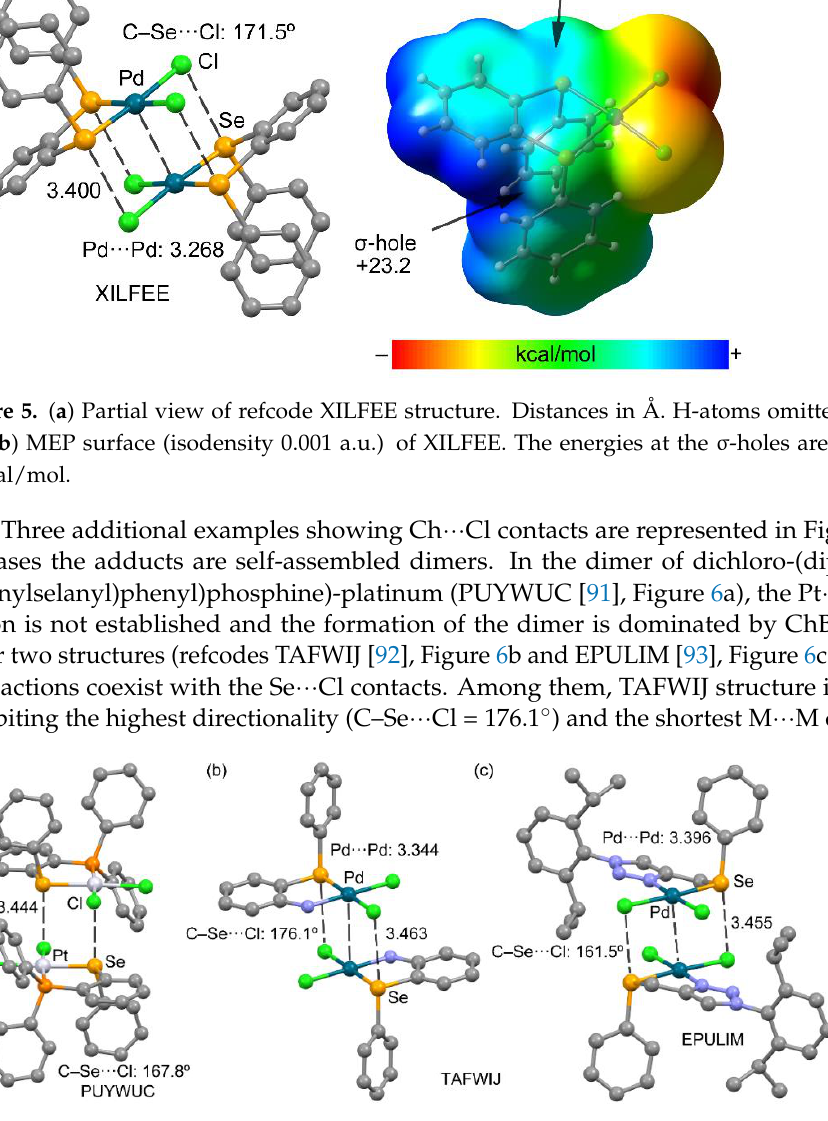
Figure 4. Partial views of the refcodes XUFHEM ( a ) and XUFHIQ ( b ) structures. Distances in Å . H- atoms omitted for clarity.